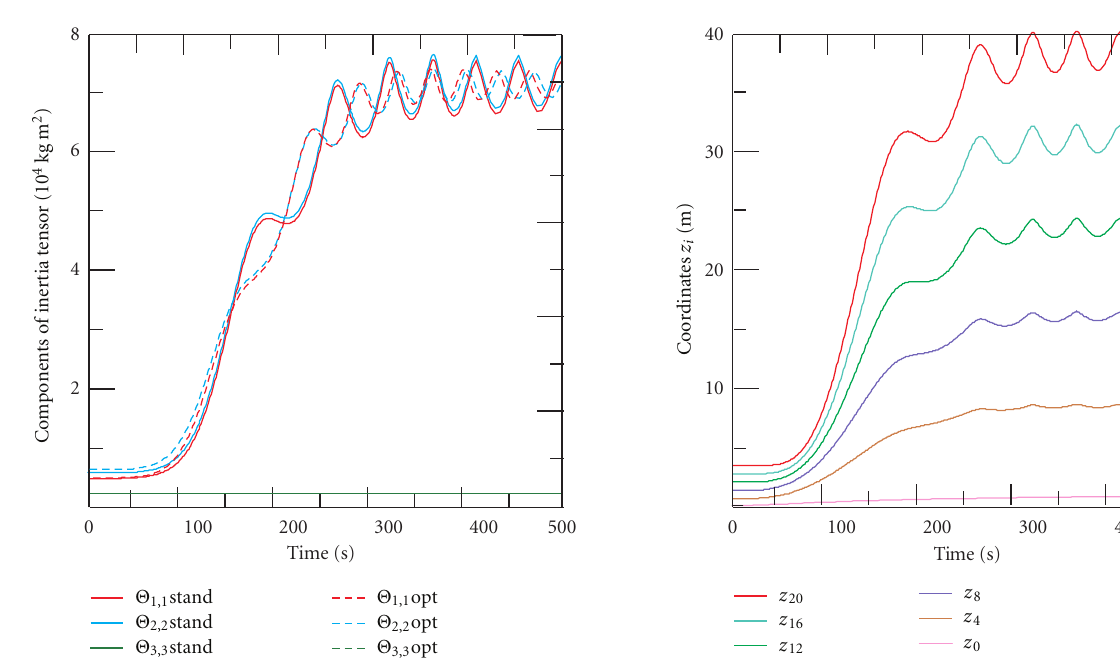
Figure 9: Time dependence of inertia tensor diagonal components.